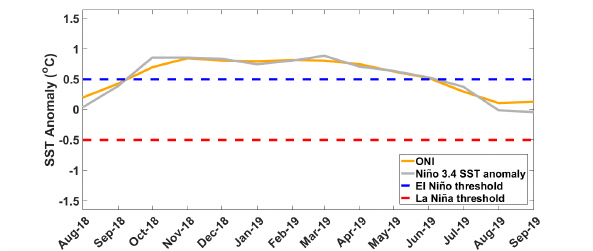
Figure 1. The ERSST v5 and ONI timeseries and the threshold for identifying ENSO events.